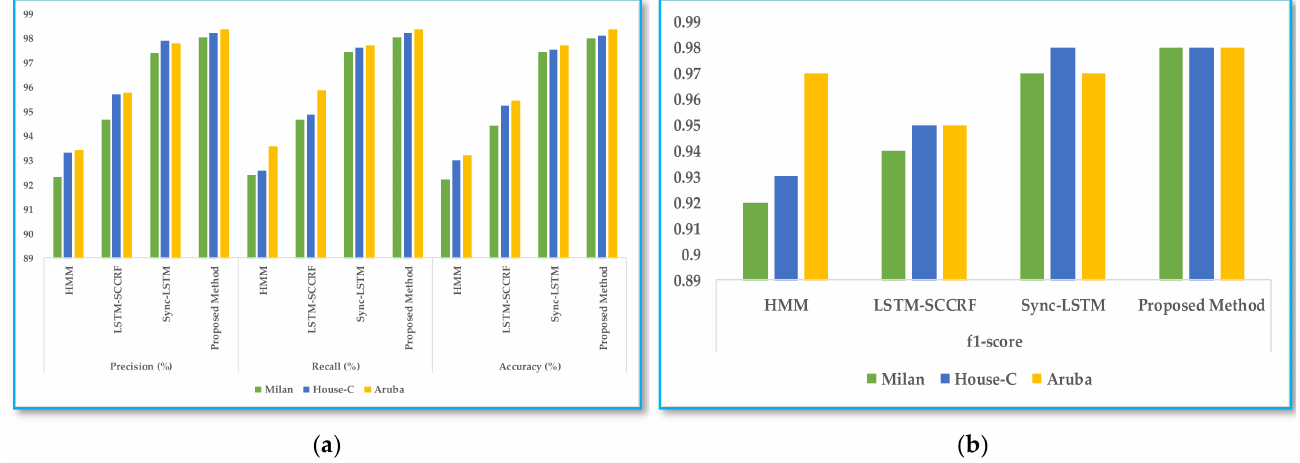
Figure 8. ( a ) the average precision, recall, and accuracy and ( b ) the f1-score comparison with different